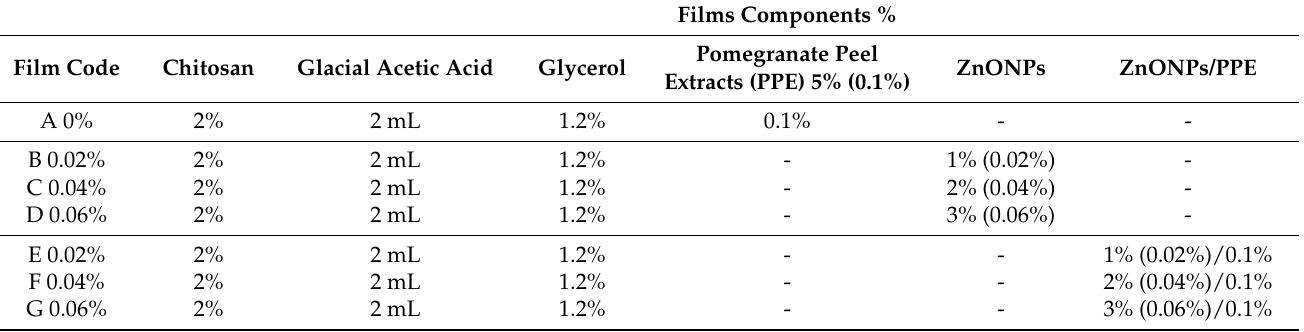
Table 1. The table shows the composition of the solubility chitosan film in glacial acetic acid, plasti- cizers such as glycerol, coefficients code, and permissible percentages of zinc oxide and pomegranate peel